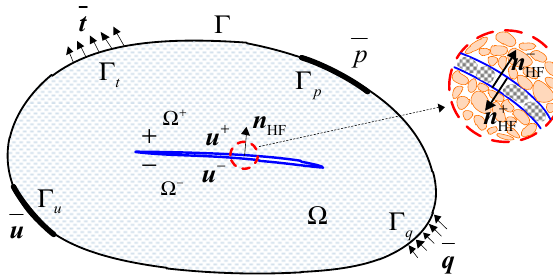
Figure 2. Sketch of a fractured porous medium and its boundaries.